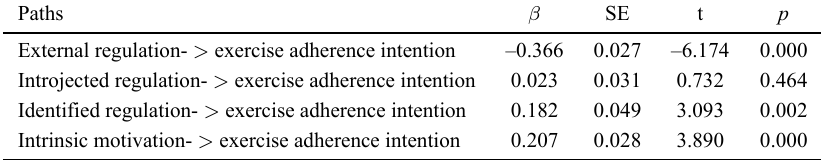
Table 4. Verification of research problem 1 based on the structural model.